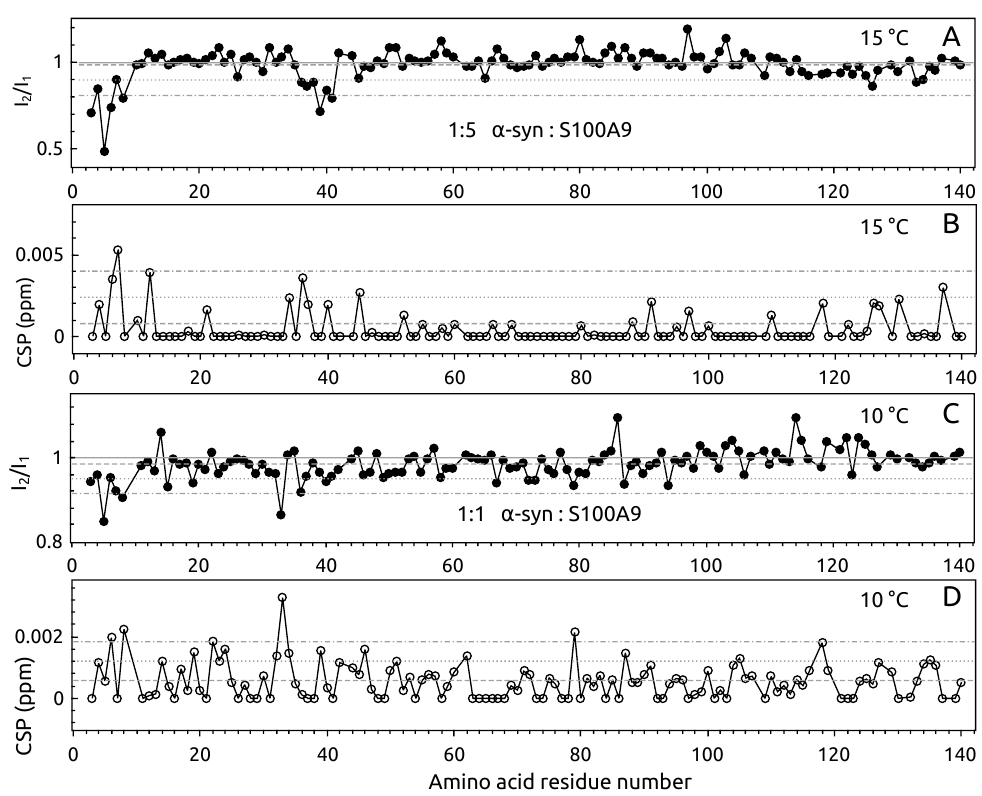
Figure A2. ( A , C ) Intensity change and ( B , D ) chemical shift perturbation (CSP) of α -syn after addition of S100A9 at ( A , B ) 15°C and ( C , D ) 10°C. Intensity change expressed as a ratio of α -syn intensities